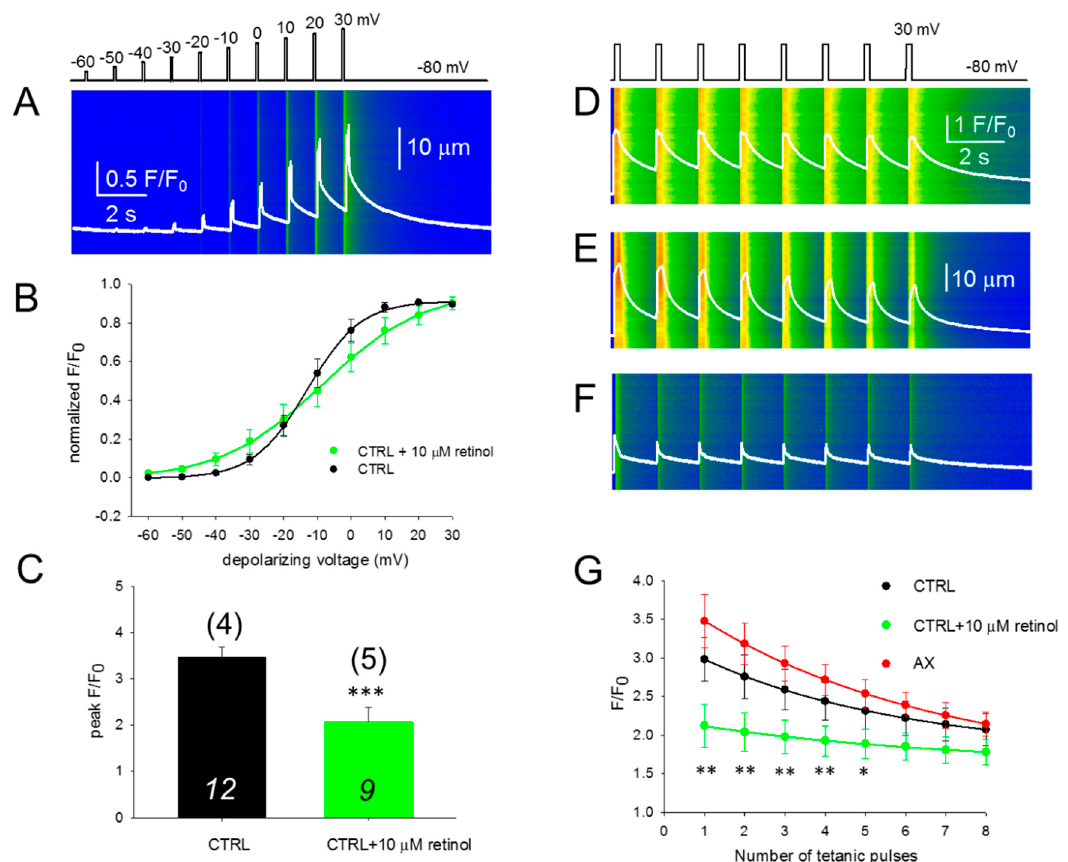
Figure 5. Acute retinol treatment alters the excitation-contraction coupling properties of FDB fibers. ( A ) Line-scan images of changes in intracellular calcium elicited by the same depolarization protocol as in Figure 3A,B. The white trace indicates the spatially averaged F(t) / F 0. ( B ) Voltage dependence of the calcium transients. Values were obtained as described for Figure 3C. Continuous lines represent the best fit of the Boltzmann function to the average values with parameters of k = 7.91 and 14.76 mV, and V 50 = –13.03 and –8.52 mV, for CTRL ( n = 12 fibers, N = 4 mice) and retinol ( n = 11 fibers, N = 6 mice), respectively. The control points are the same as in Figure 3C. ( C ) Normalized peak fluorescence at close to maximal depolarization ( + 10 mV). Values were averaged after normalization to the maximum of the individual Boltzmann fits. *** denotes significant di ff erence ( p < 0.001) between CTRL and retinol. ( D – F ) Representative line-scan images illustrating the fatigability of the FDB fibers in CTRL ( D ), AX ( E ) and retinol ( F ) treated cells. The calcium transients were elicited by a train of depolarizing pulses to + 30 mV with 1.5 s delay, lasting 200 ms each. The scale corresponds to all three line-scans. ( G ) The normalized fluorescence was plotted for each pulse and single-exponential functions were fitted to the points to assess the F / F 0 decline. The * and ** denote significant di ff erences between AX and retinol at the given tetanus at p < 0.05 and p < 0.01, respectively. The numbers in italics indicate the number of cells studied, whereas the numbers in parenthesis denote the number of animals